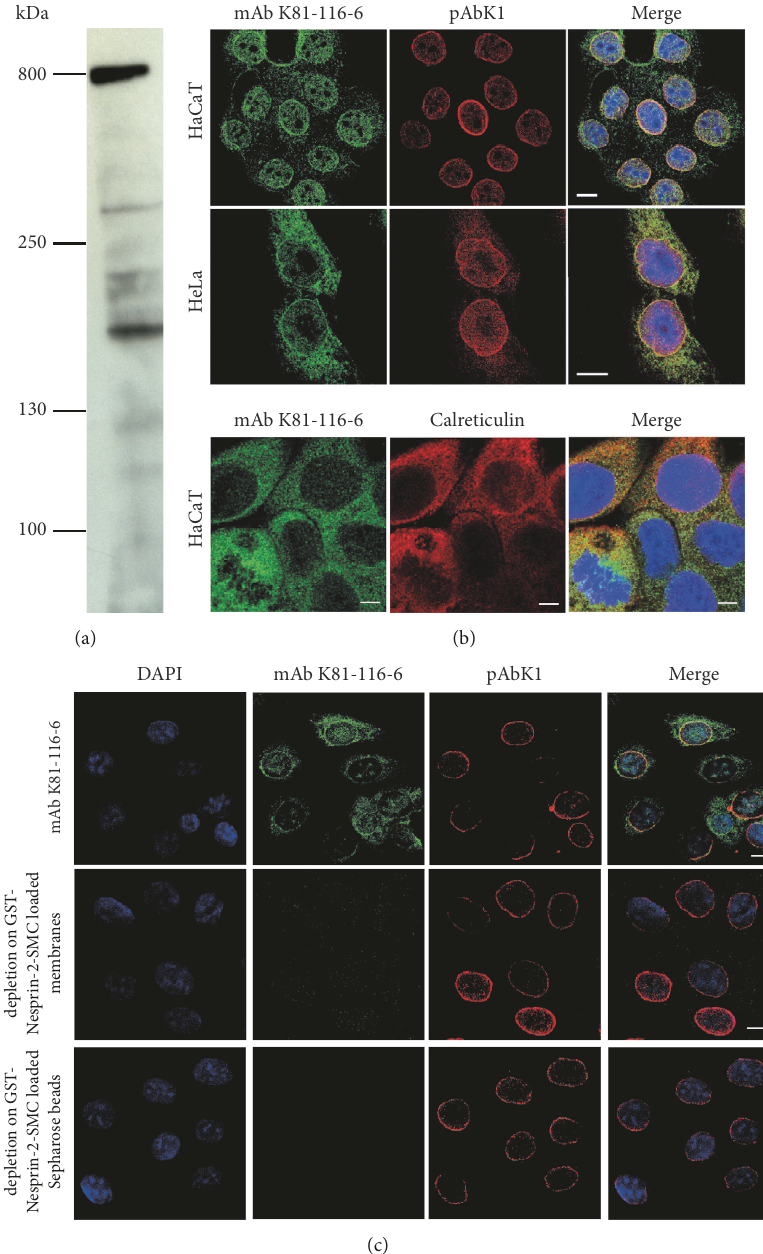
Figure 2: Characterization of monoclonal antibodies directed against the SMC domain. (a) Detection of Nesprin-2 with mAb K81-116-6 in HaCaT cell lysates. Proteins were separated by SDS-PAGE (3–12% acrylamide). (b) mAb K81-116-6 staining of HaCaT and HeLa cells. pAbK1 was used as bona fide Nesprin-2 antibody. DAPI stains the DNA (in Merge). Bar, 10 𝜇 m. Lower panel, colocalization of Nesprin- 2 detected by mAb K81-116-6 with ER marker calreticulin in HaCaT cells. Bar, 5 𝜇 m. (c) Analysis of the specificity of mAb K81-116-6. Antibodies were depleted from the hybridoma supernatant by the indicated procedures. Antibody depleted supernatants were then used for immunofluorescence analysis. Bar, 10 𝜇